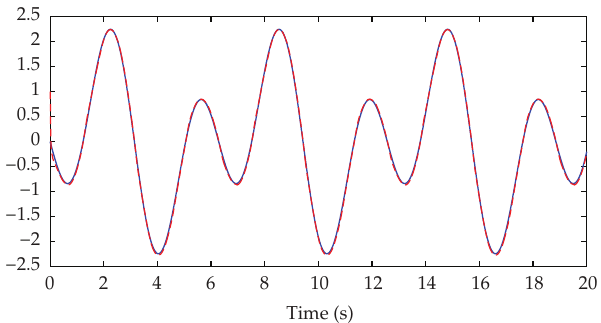
Figure 1: Tracking process: reference trajectory: solid line; system output: dashed line.